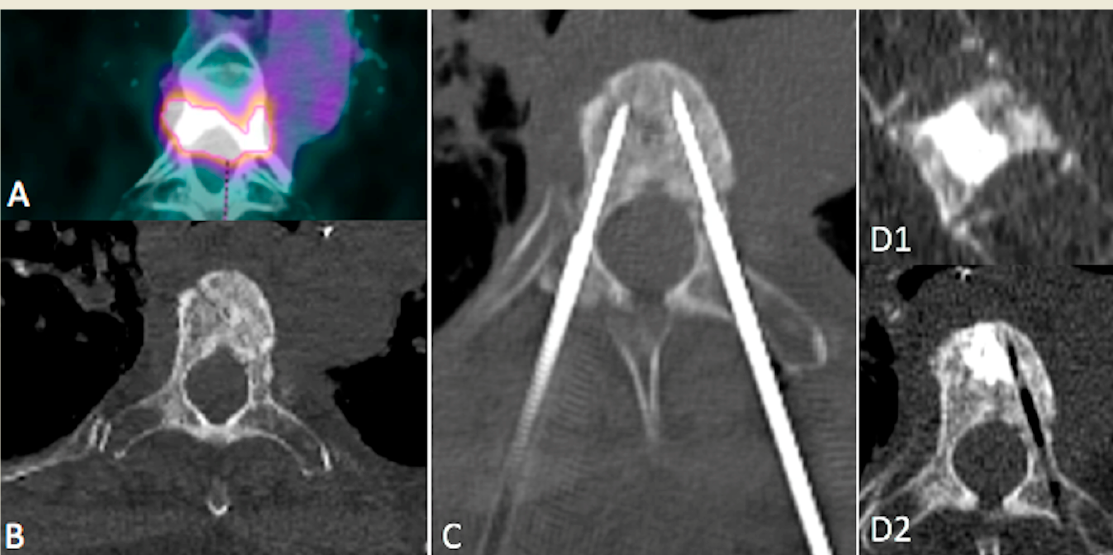
Figure 1. Axial MRI after gadolinium injection ( A ) and CT ( B ) showing a sclerotic-enhancing lesion of the vertebral body of fifth thoracic vertebra. ( C , D ): CT images showing the radiofrequency probe at target site in the lesion during thermo- ablation session.